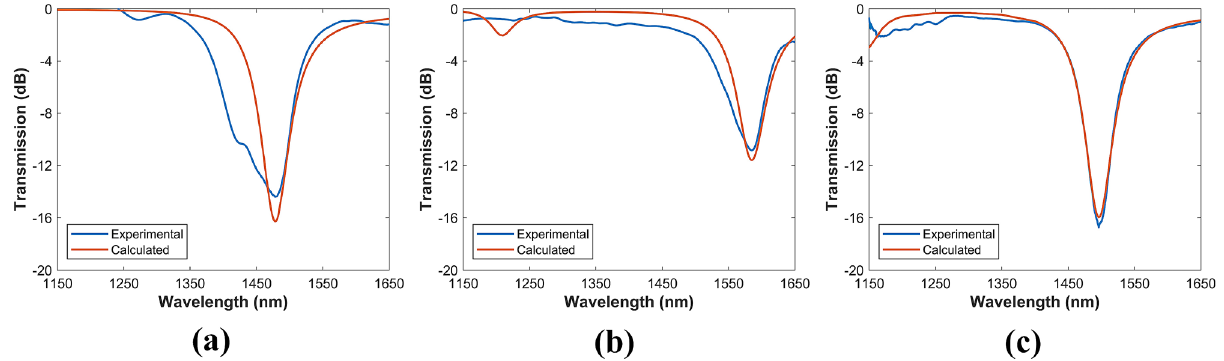
Figure 4. Transmission spectra of the coated D-shaped fibers. ( a ) 3-layer 1DPC, ( b ) 5-layer 1DPC, and ( c ) 6-layer 1DPC. The blue and red lines represent the experimental and the calculated spectra, respectively. The external RI is 1.3325